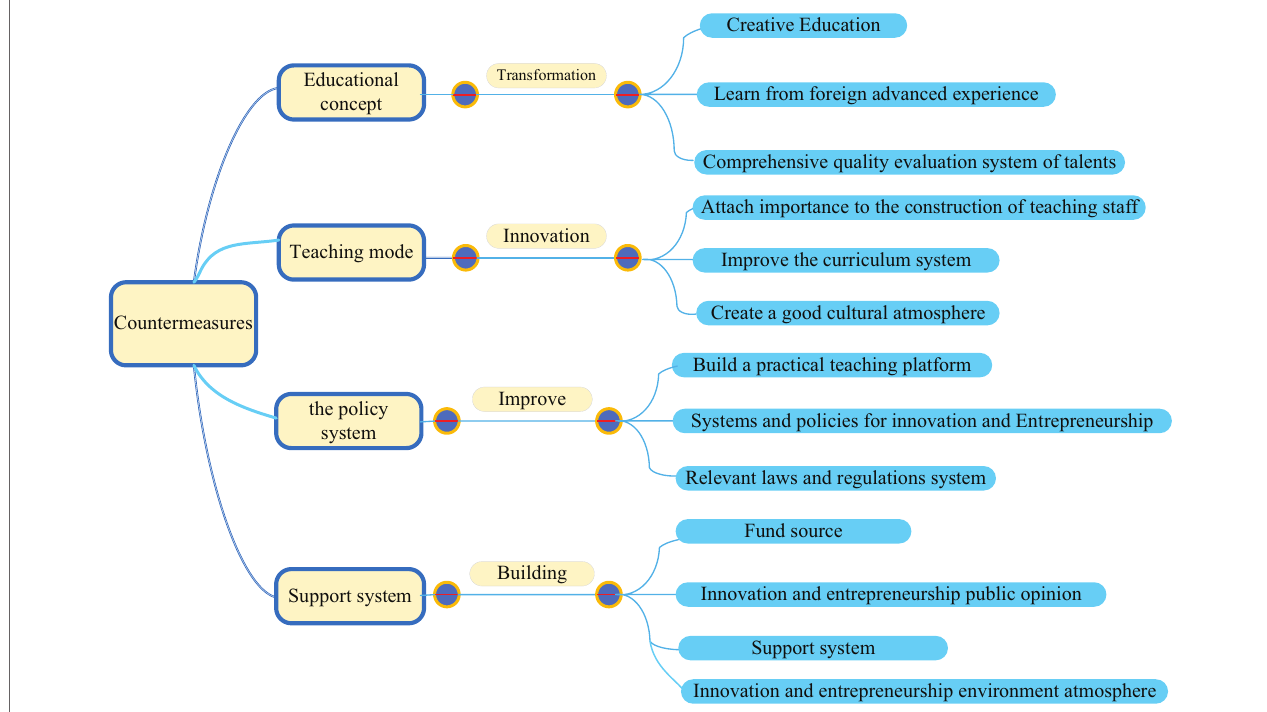
FIGURE 17 | Strategies for cultivating applied innovative talents in College